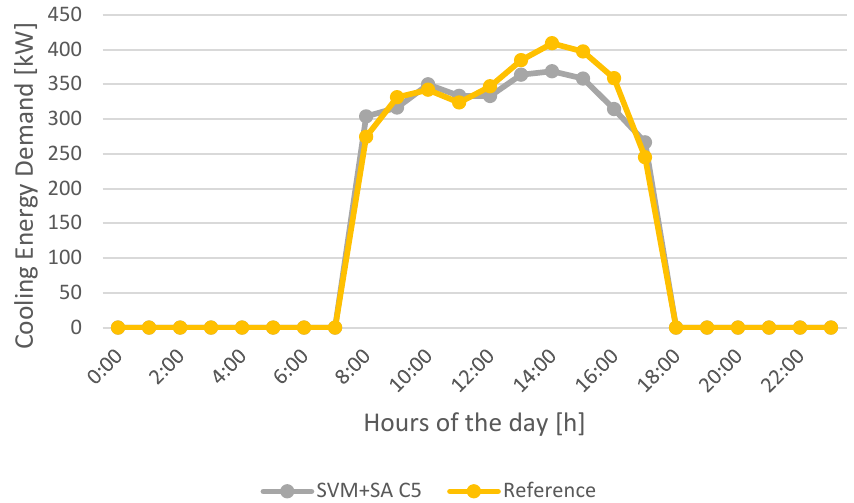
Figure 19. Load profile comparison between SVM + SA model C5 and reference for the cooling period.